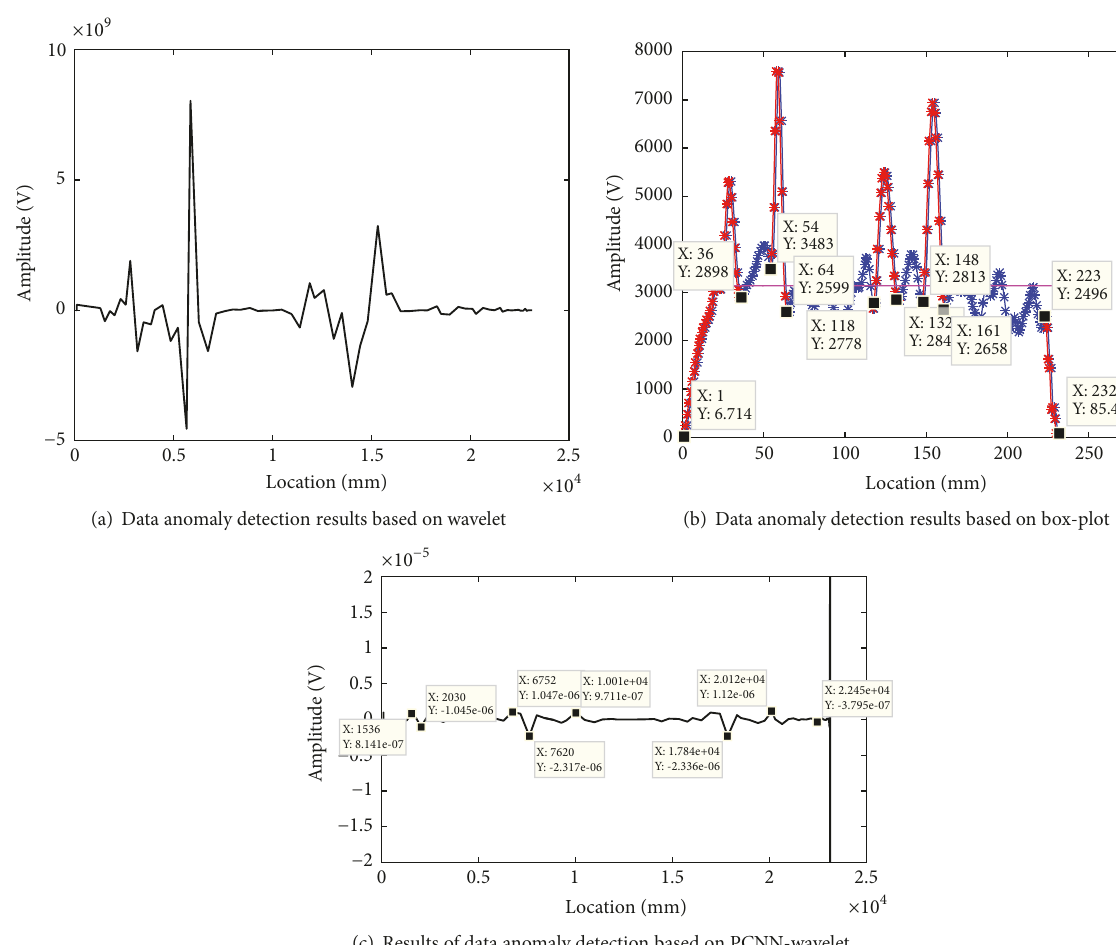
(c) Results of data anomaly detection based on PCNN-wavelet Figure 10: Comparison of abnormal point detection of three methods.